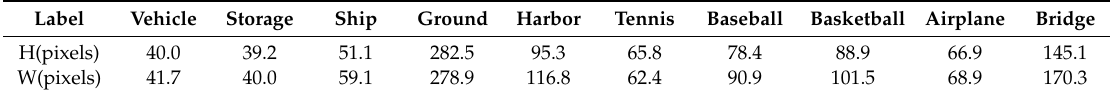
Table 1. Statistics of the average width and length of all the objects of each category in the NWPU VHR-10